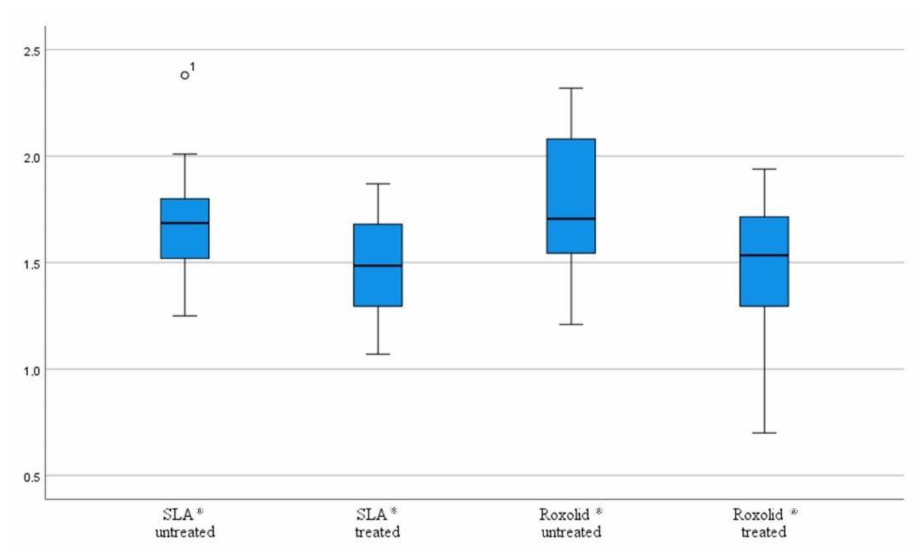
Figure 10. Mean roughness values of the two implants SLA ® and Roxolid ® as a boxplot. (Number 1 at the SLA®untreated shows a statistical